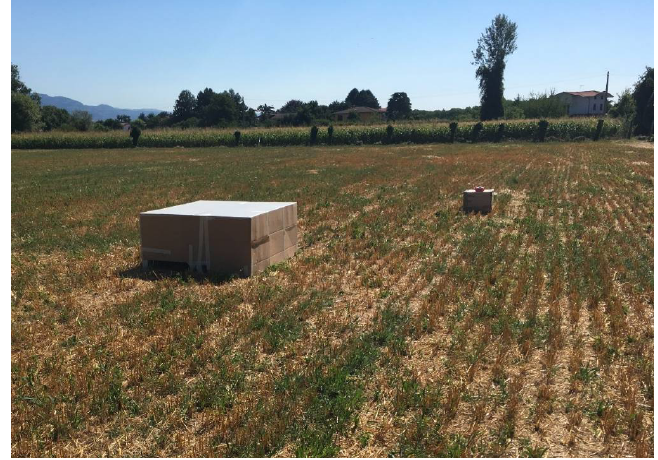
Figure 8. The test area with the target (biggest box) used to assess the accuracy of LasUAV in in-flight conditions.